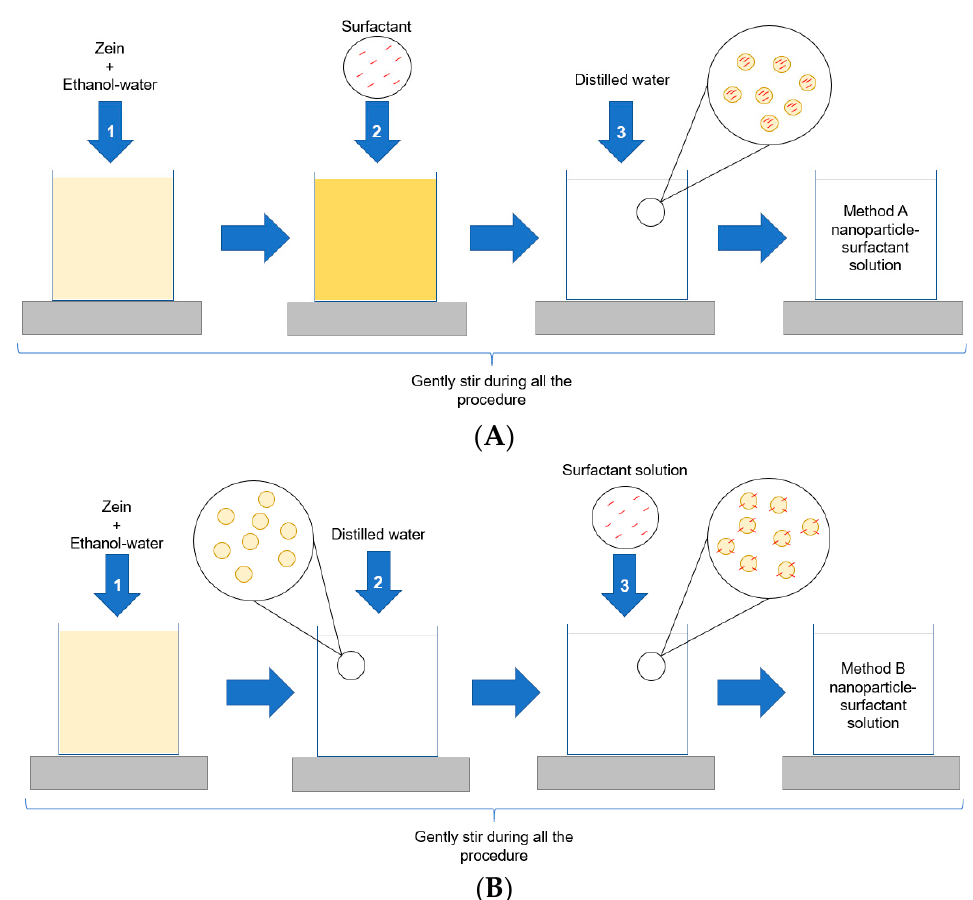
Figure 18. Methods used for the preparation of zein nanoparticles containing the arginine surfactants: Method ( A )—zein and surfactants are pre-mixed before the nanoparticles´ formation. Method ( B )—the surfactants are added to pre-formed zein nanoparticles.